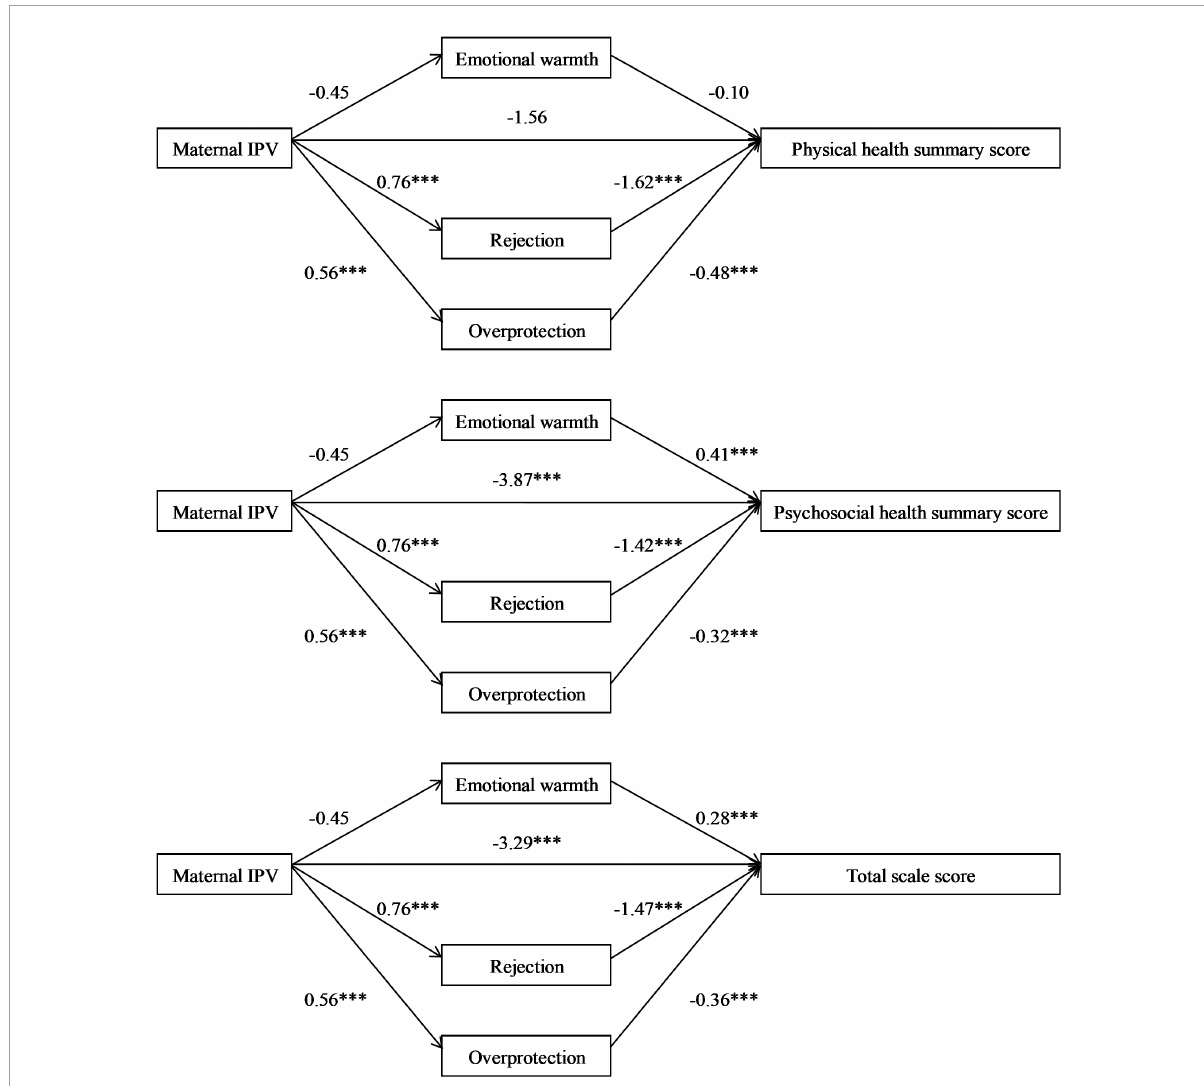
FIGURE3 Mediating effect of parenting styles between maternal IPV and summary scores of children’s HRQOL. IPV, intimate partner violence; HRQOL, health-related quality of life. (Adjusted for children’s age, gender, status of single child, sleep duration, primary caregiver, maternal age, current marital status, educational level, and monthly per-capita income). ∗∗∗ p <